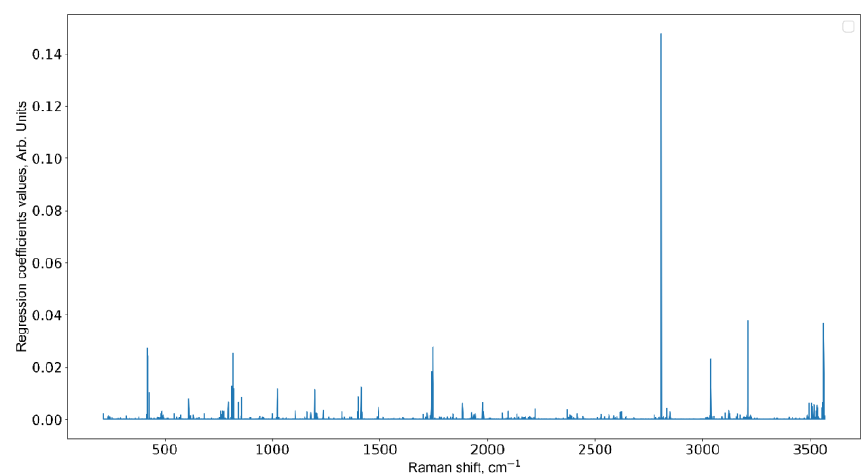
Figure 9. Important features (Raman shifts) for the constructed regression model.